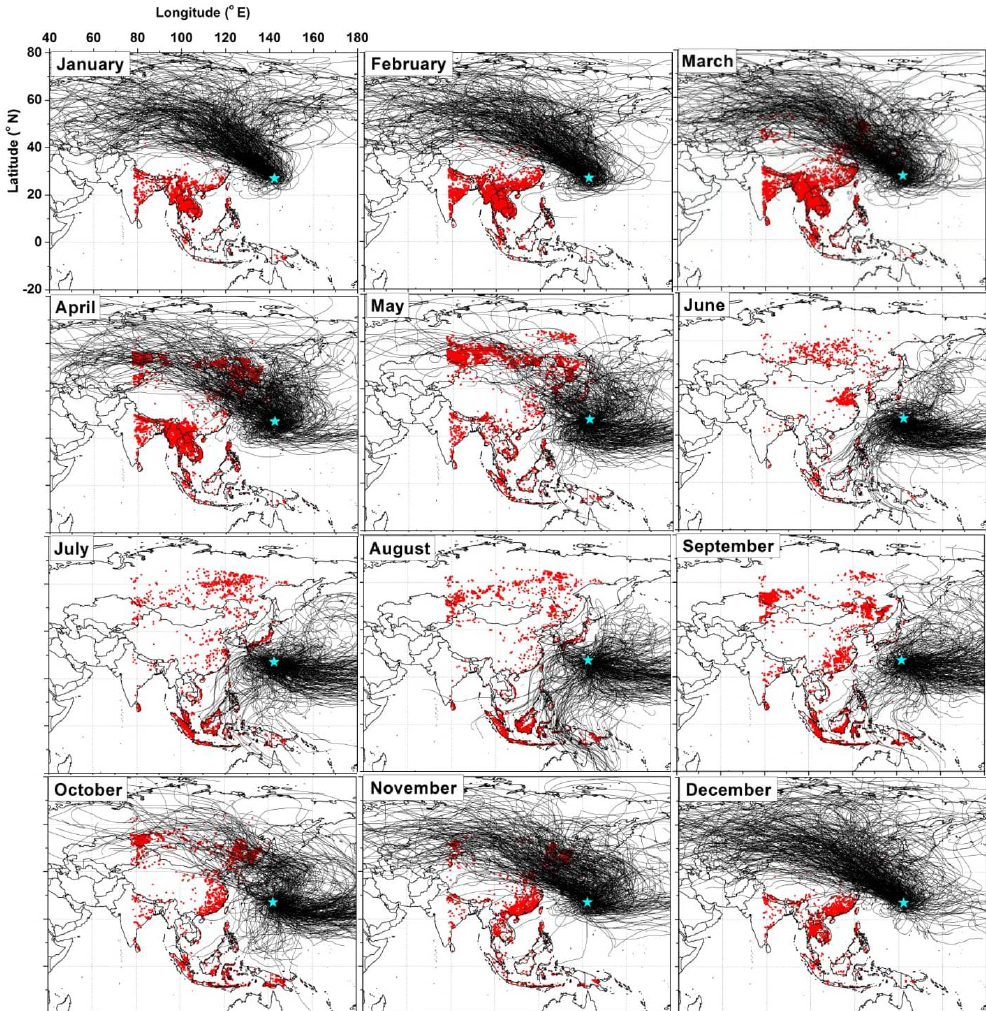
Figure 2. Seven-day daily air mass back trajectories at 500ma.g.l. computed using HYSPLIT model for each month during 2001–2012 at Chichijima in the western North Pacific. The star symbol indicates the sampling site and red dots represent the MODIS inferred fire spots. Fire spots were downloaded for the region (80–150 ◦ E, − 10–70 ◦ N) during the year